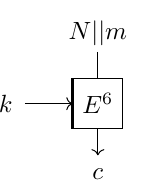
Figure 9: Saturnin -Short with key 𝑘 , message 𝑚 and nonce 𝑁 . A thick line represents the input of the